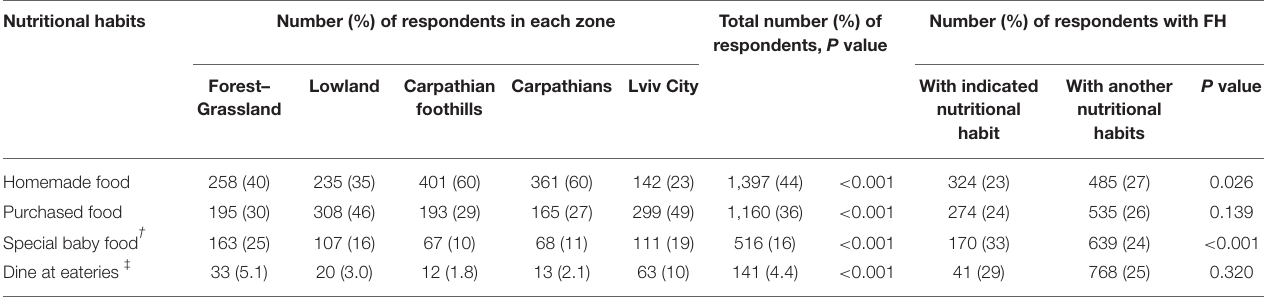
TABLE 8 | Nutritional habits among children of different geographic and climate zones * . Nutritional habits Number (%) of respondents in each